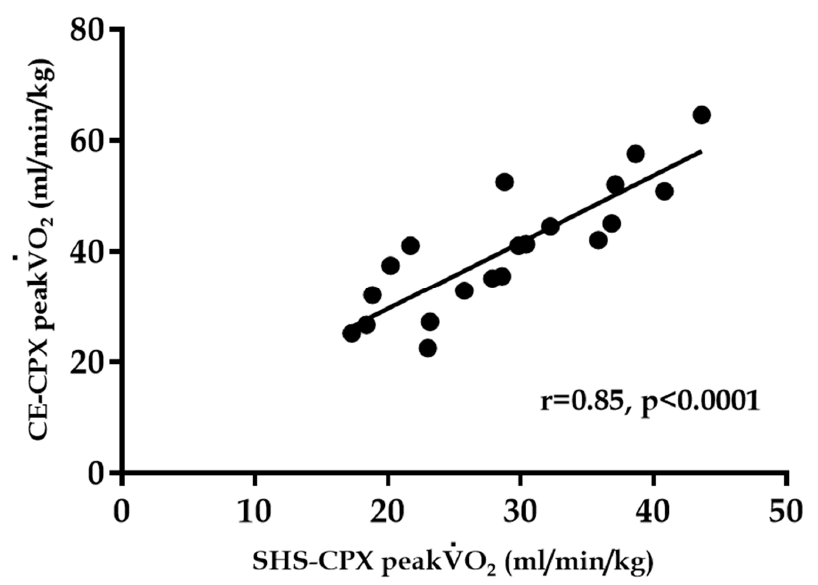
． . VO 2 obtained during CE-CPX and that O 2 obtained during CE-CPX and that ob- ． O 2 : oxygen uptake.